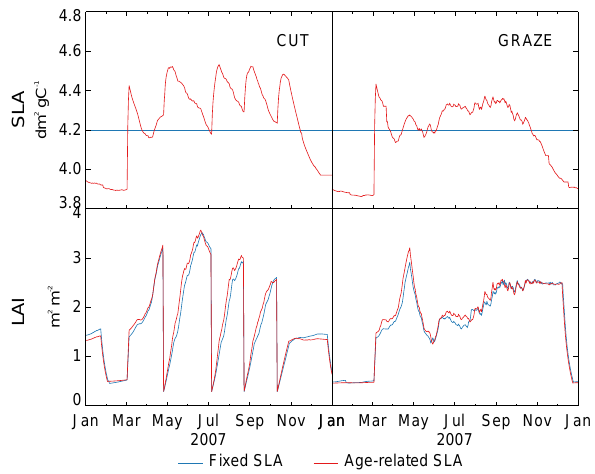
Figure 3 1028 Fig. 3. Age-related SLA and its impact on LAI. Results are simu- lated by ORCHIDEE-GM with fixed SLA and age-related SLA re- spectively on a mowed grassland (CH-Oe1) and a grazed grassland (FR-Lq1) for the year 2007.